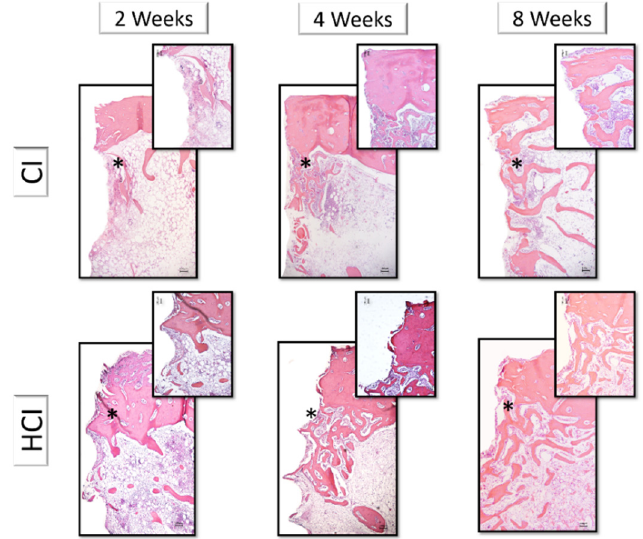
Figure 7. Histological images representative of decalcified sections of implants with different macrostructures and in different experimental periods . CI: Cylindrical Implant and HCI: Hybrid Conical Implant. Both in the periods of 2, 4 and 8 weeks. 5× and 10× magnification.